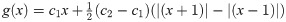
Schematic of a simple electronic circuit, known as the MLC circuit [1], implementing the rescaled dynamical equations given in Eq 1.In the circuit, the voltage across the capacitor C, the current through the inductor L and the external forcing signal g(t) correspond to x, y and b + I + f(t) in Eq 1 respectively. The nonlinear element N is the Chua’s diode implemented as in [1], with rescaled piecewise-linear characteristic curve g(x)=c1x+12(c2-c1)(|(x+1)|-|(x-1)|).